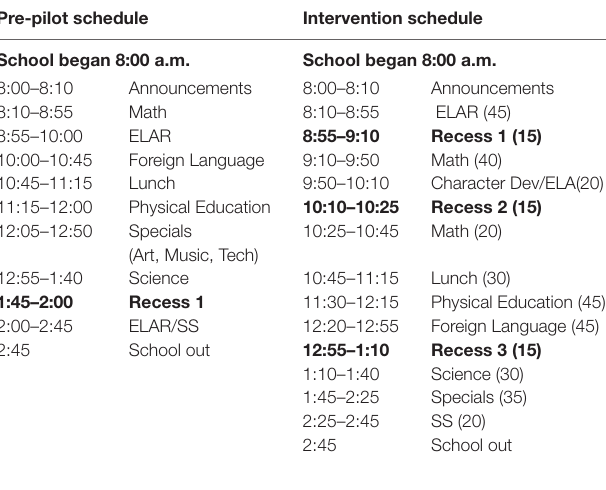
TaBle 1 | Comparison of baseline school schedule and intervention